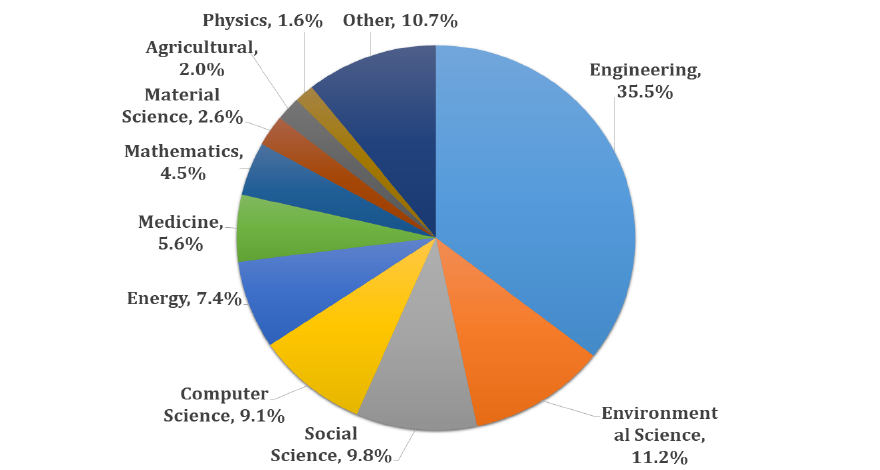
Figure 6. Interest in Considering OB by